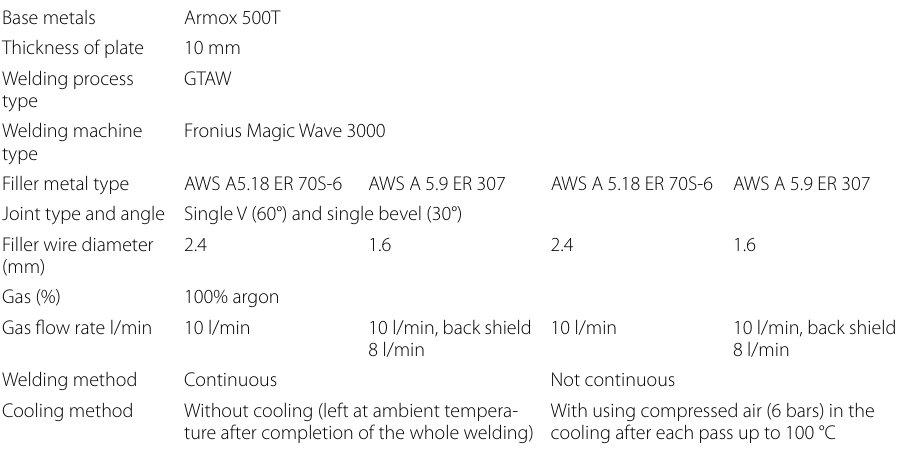
Table 6 Welding procedure